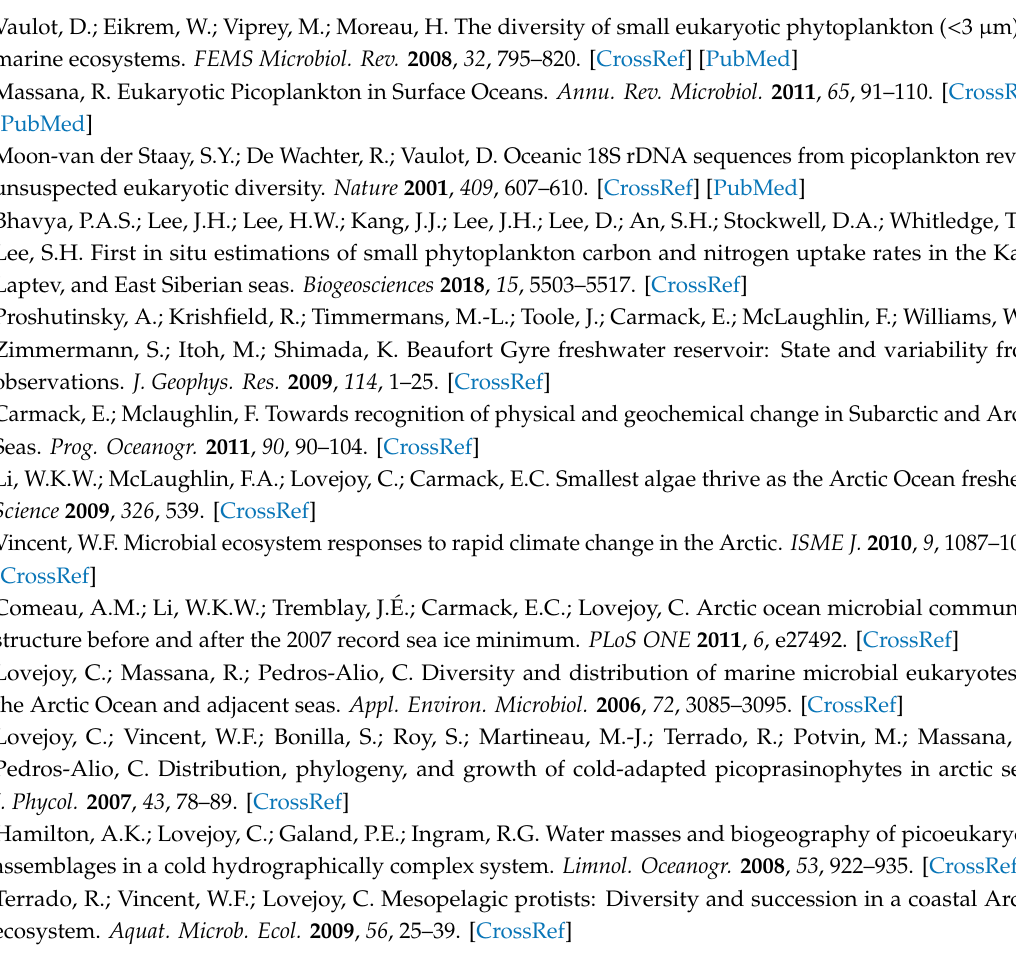
Figure S1. Air temperature at the White Sea Biological Station (shaded area corresponds to sampling